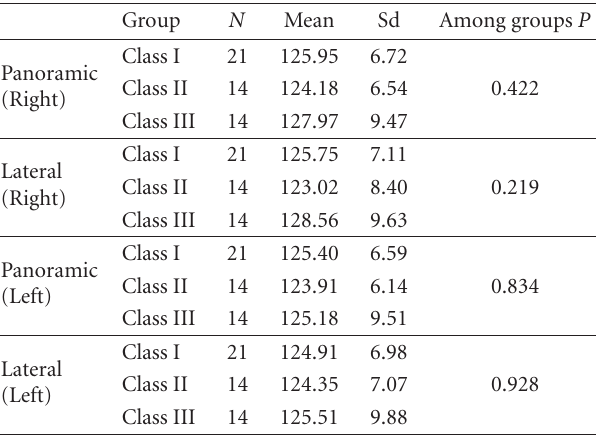
Table 2: ANOVA test revealed P values related to the gonial angle in LCR and PR according to the right and left sides. Group Among groups P